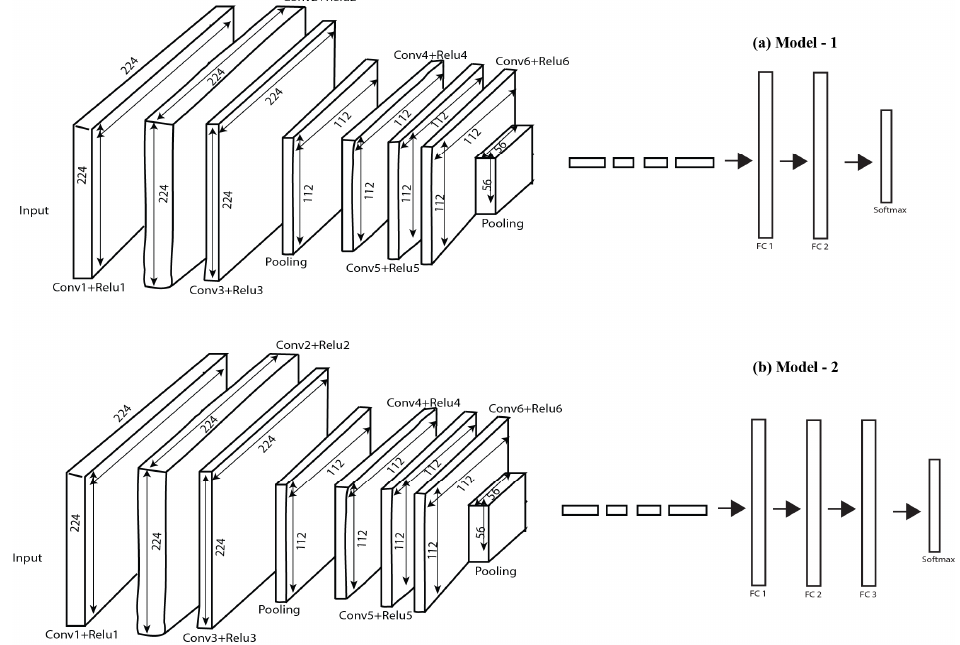
Figure 3. Architecture of the proposed fish identification and classification models.